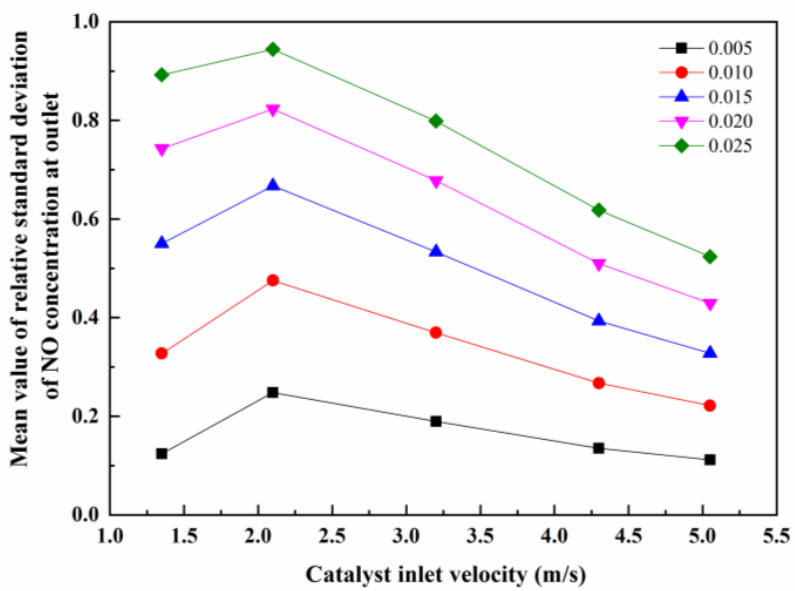
Figure 25. Relationship between mean velocity and relative standard deviation of outlet NO concen- tration under different relative standard deviations of temperature.